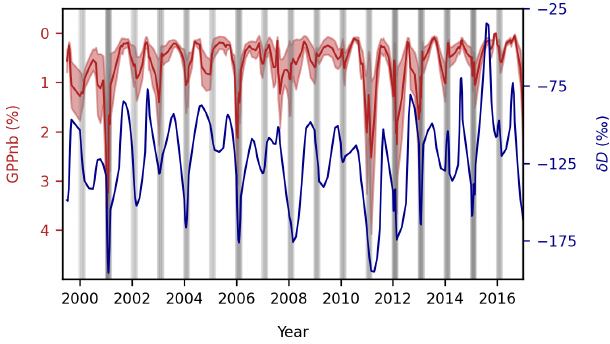
Figure 3. Relationship over the 18-year record between the percent- age of giant particles with respect to the total dust particle number (GPPnb, reverse scale) and the δ D. Gray shaded vertical bands cor- respond to the wet season for each calendar year. Uncertainties for each GPPnb value (expressed by the red shaded area) are relative to the standard deviation between Coulter counter measurements. All data are reported as the 3-point running average of the data previ- ously resampled at